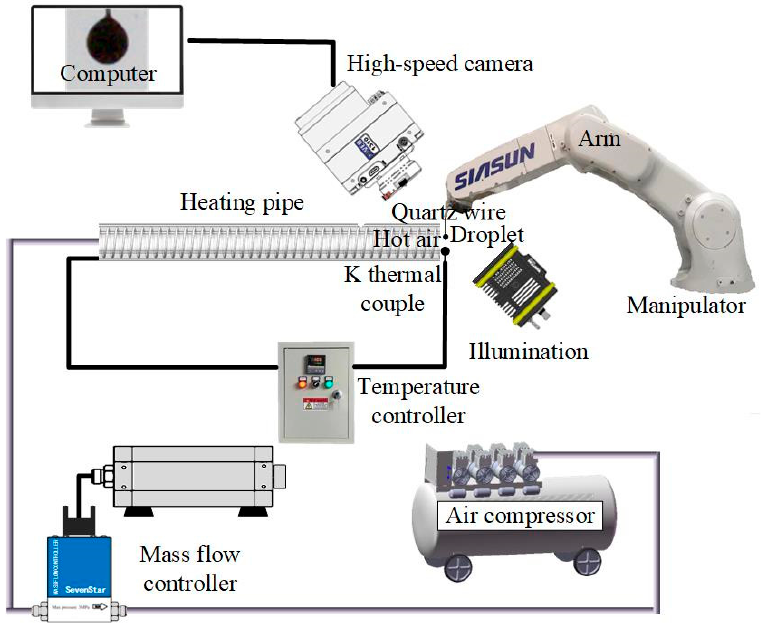
Figure 3. Schematic of experimental setup.